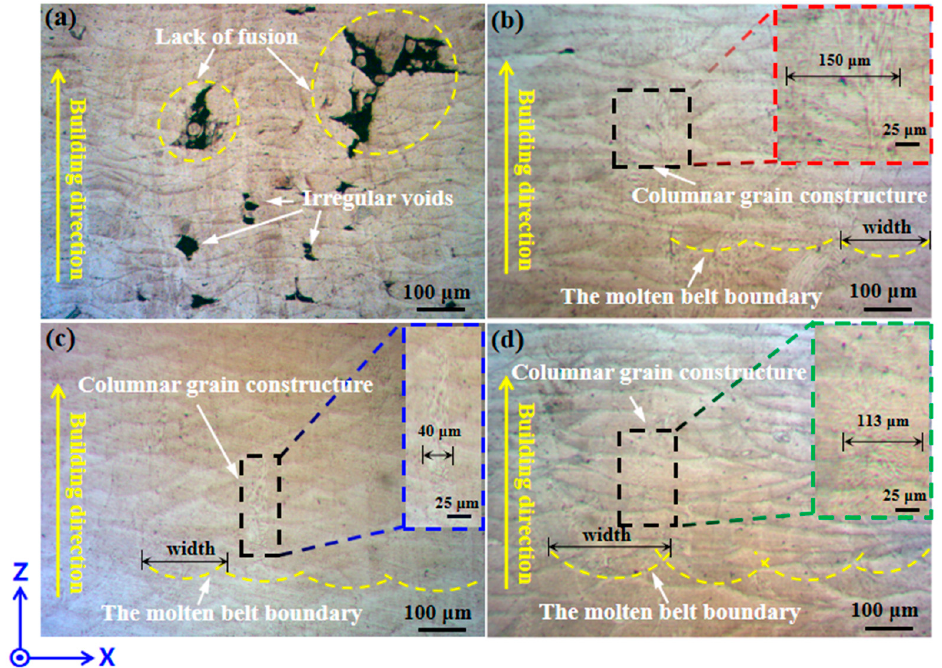
Figure 4. Optical micrographs of the as-SLMed IN718 samples on vertical section (X–Z plane) at the E v s of ( a ) 41.67 J/mm 3 , ( b ) 85.86 J/mm 3 , ( c ) 100 J/mm 3 , and ( d ) 117.17 J/mm 3 . Figure 4 also indicates the microstructure of the as-SLMed IN718 samples exists with a certain number of columnar grains and dendrites, as circled by the black dashed rec- tangle. Continuous dendrites, up to even several millimeters in length, grow along the deposition direction and through several melt pools, as shown in the black dashed rec- tangle. The growth direction of the dendrites is not exactly parallel to the building direc- tion, declining at an angle to the building direction. The width of the columnar grains ranges from 40 μ m to 150 μ m. The columnar grains become smooth and fine at the E v of 100 J/mm 3 , while they become coarse and large at E v s of 85.86 and 117.17 J/mm 3 . The interface between two adjacent cladding layers is clear without any change in the columnar grains. For the sample at the E v of 117.17 J/mm 3 , shown in (Figure 4d), the columnar grains are discontinuous. This is believed to be from the different microstructure between the bottom region of the melt pool (planar interface growth) and the other regions (dendrite growth) [46,47]. The microstructures on the X–Y plane of the SLMed samples at different E v s are shown in Figure 5. A close connection between the densification of the sample and the laser energy density has been found. At the E v of 41.67 J/mm 3 , the insufficient energy